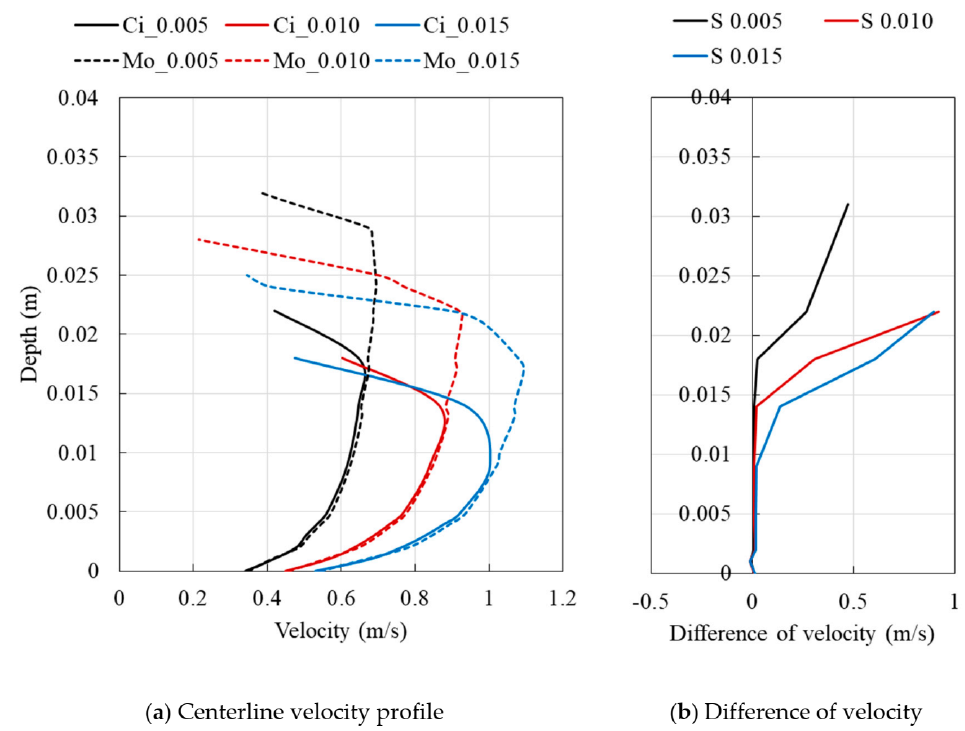
Figure 7. Centerline velocity profile ( a ) and their di ff erences ( b ) (Ci: circular pipe, Mo: complex cross-section module, the numbers beside Ci and Mo are slope, S: slope).